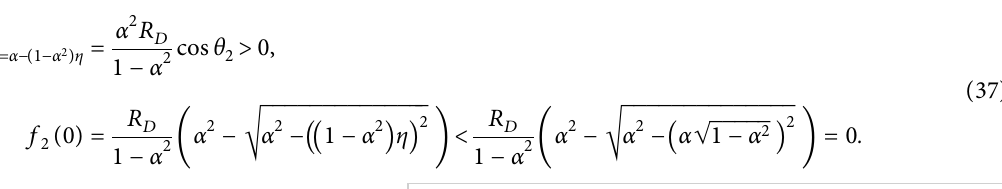
I 2 P , P and the related Apollonian